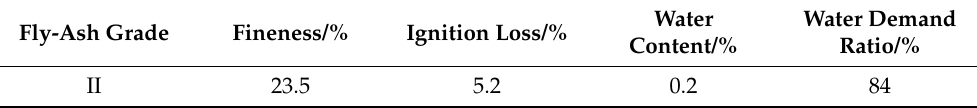
Table 2. Fly-ash performance index of Guizhou Huadian Tangzhai Power Generation Co., Ltd.